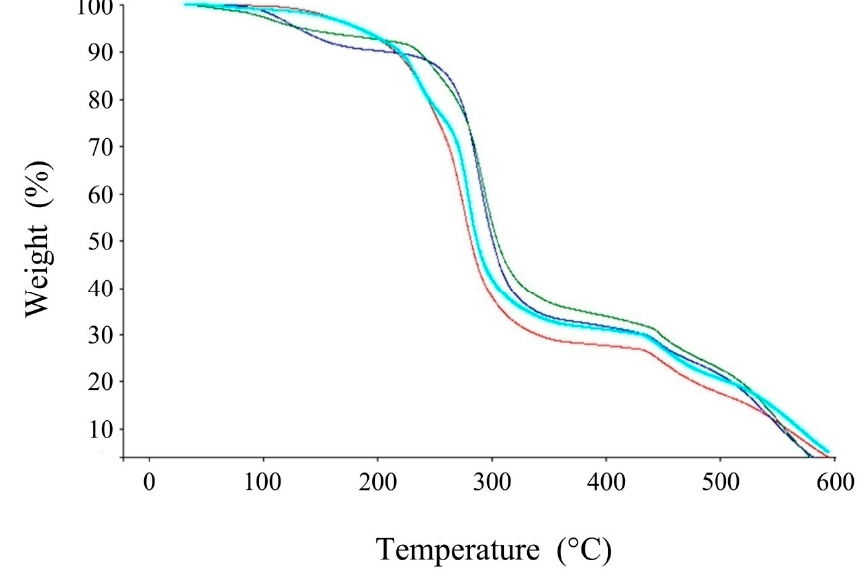
Figure 4. TGA profiles of PVC (dark blue) and different polymer inclusion membranes: PVC/DBP (red), PVC/poly( β -cyclodextrin) (green) and PVC/DBP/poly( β -cyclodextrin) (light blue). Each experiment was performed in triplicate.